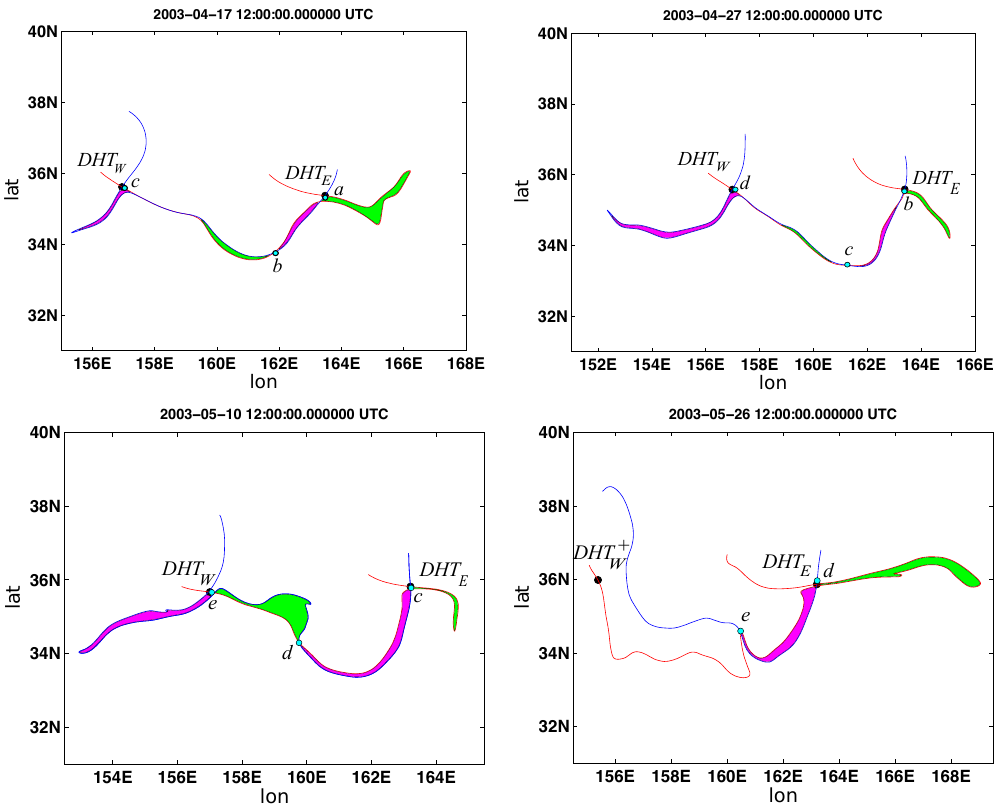
Fig. 8. Sequence of lobes between 17 April 2003 and 26 May 2003 mixing waters from north to south and viceversa at the Kuroshio